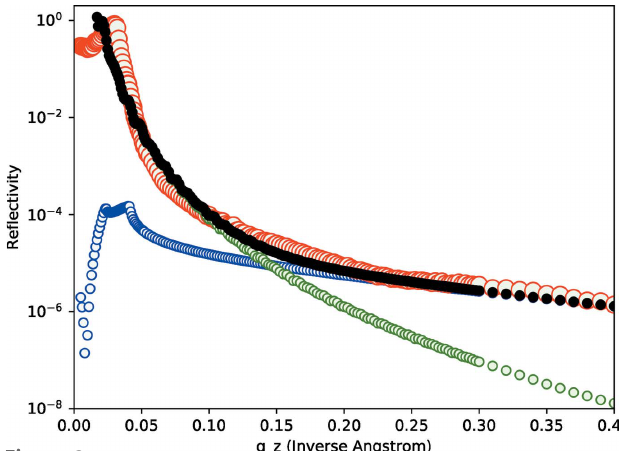
Figure 9 Smooth sample: measured longitudinal scattering data for an angular offset of 0.05 (cid:10) (red), calculated specular scattering in the BA (green), calculated diffuse in the DWBA (blue), and total calculated scattering